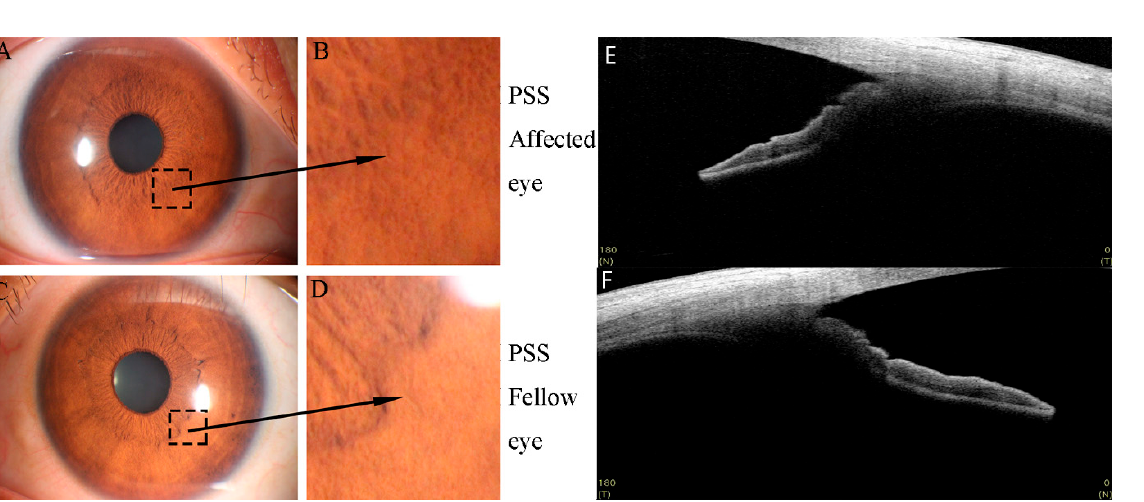
Figure 2. The iris of PSS-affected and fellow eyes (observed by slit lamp microscope: ( A – D ) and by SS-OCT: ( E , F ). Compared with PSS fellow eye ( C , D , F ), PSS-affected eye ( A , B , E ) showed significant iris atrophy.